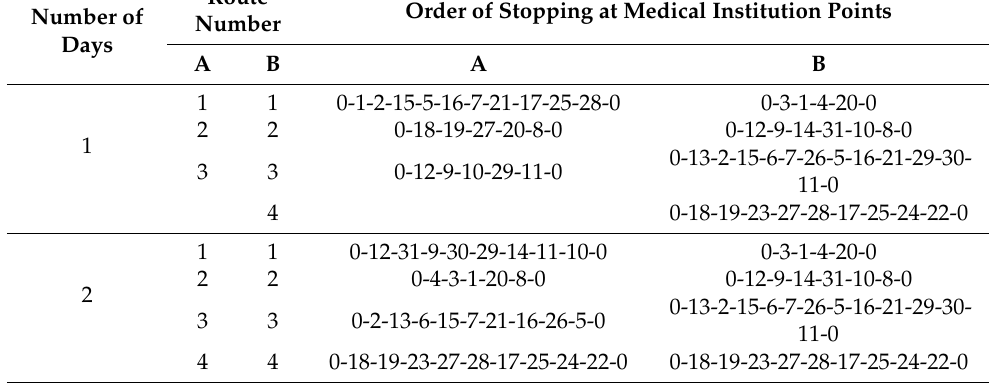
Table 6. Optimal route for medical waste recycling vehicles with and without considering the cyclical recycling